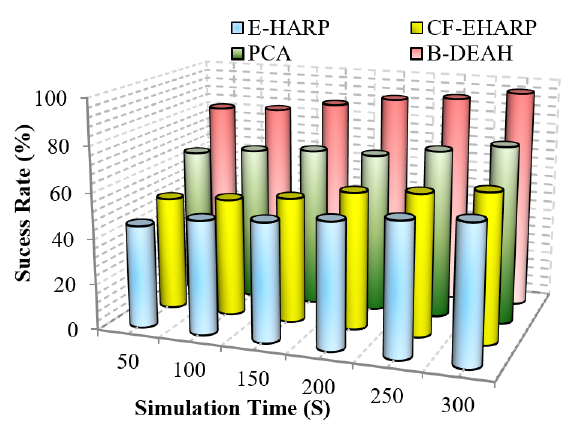
Figure 19. Success rate vs. simulation time (periodic